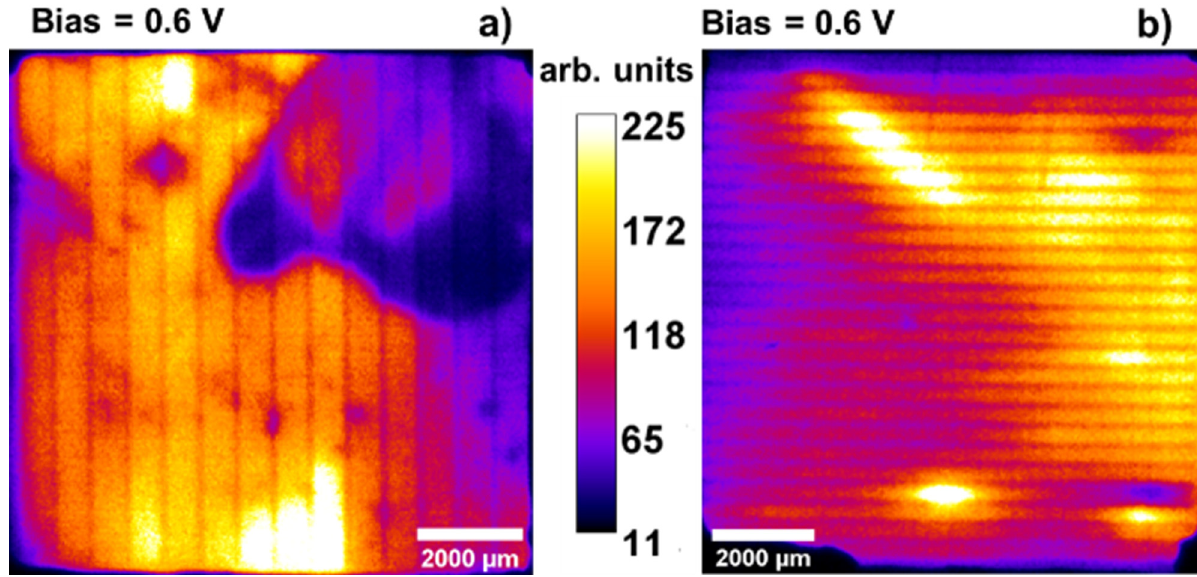
Fig. 6. EL image of Si-IBC-1 (a) and Si-IBC-2 (b) at 0.6 V bias corresponding to low injection (10 mA) current operating mode.